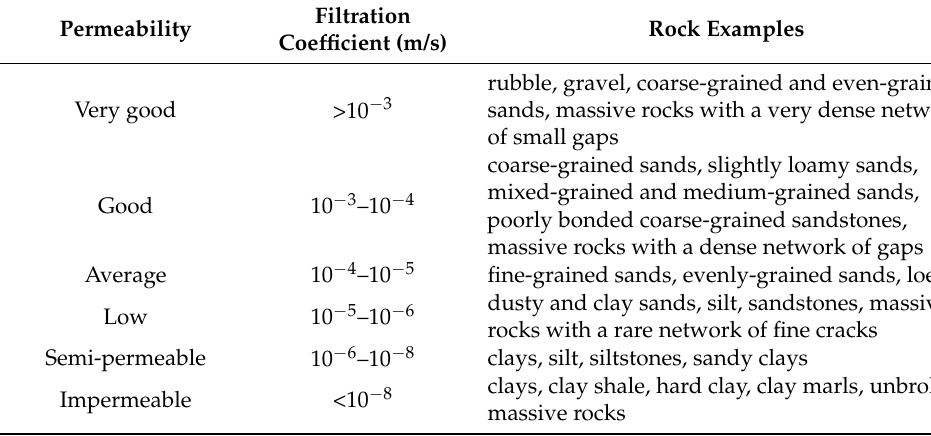
Table 1. Classification of rocks according to filtration properties.